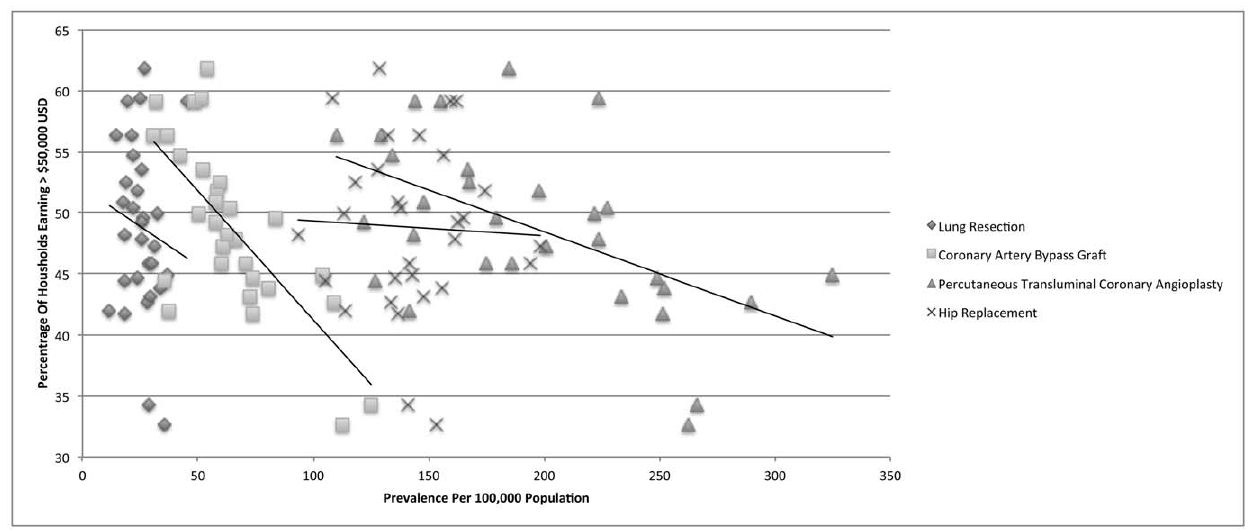
Figure 3. Income is strongly correlated with the prevelance of advanced coronary artery disease.